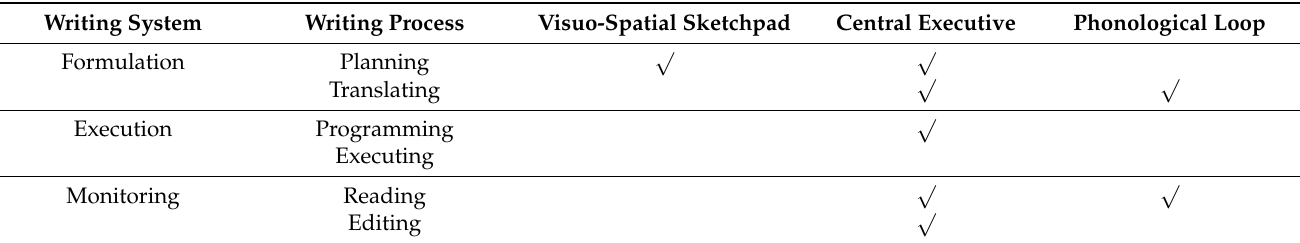
Table 2. Kellogg’s (1996) Model of Working Memory in L1